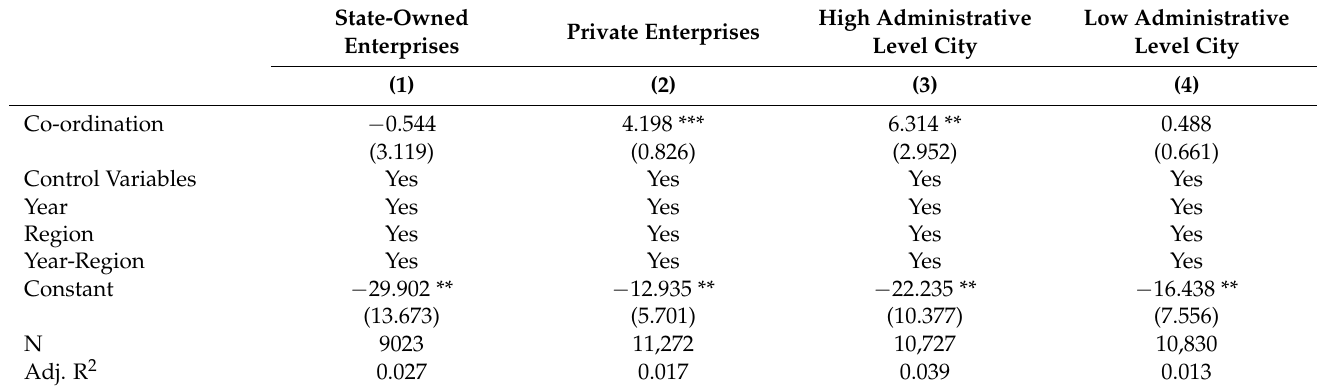
Table 10. Heterogeneity test of enterprise ownership and urban administrative